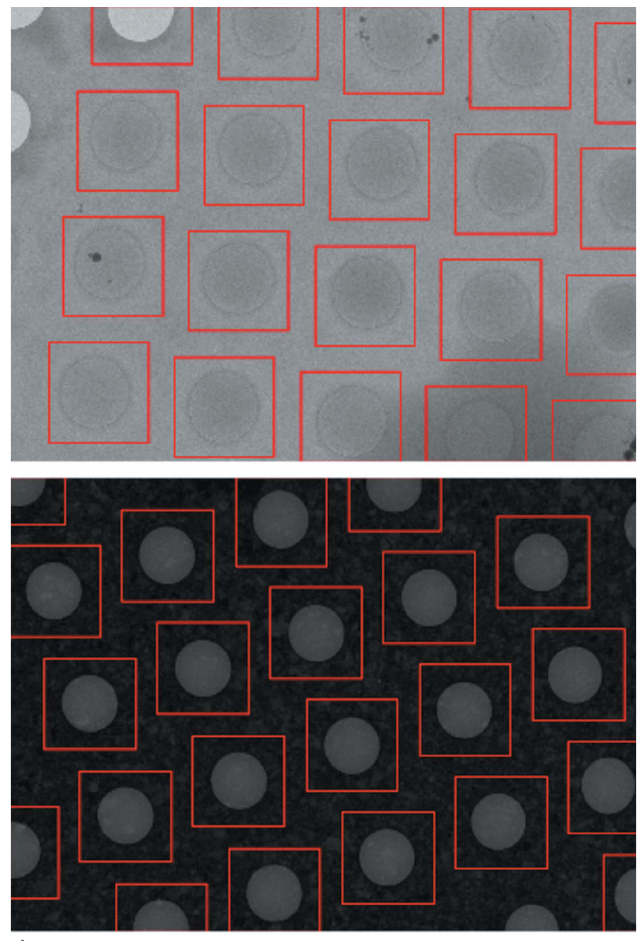
Figure 11 Examples of hole localization using the U-Net + Lattice Fitting. Ptolemy successfully detects all holes across a wide range of hole sizes, brightness and contrast conditions, from easily visible gold grids (bottom left) to very low contrast carbon grids that are difficult to see even for humans (top